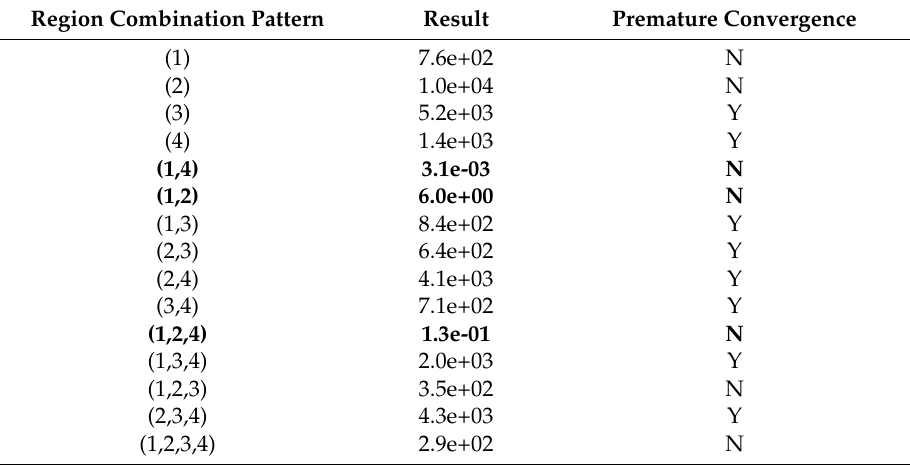
Figure 3. Parameter region division. Table 1. Results for all region combination patterns.